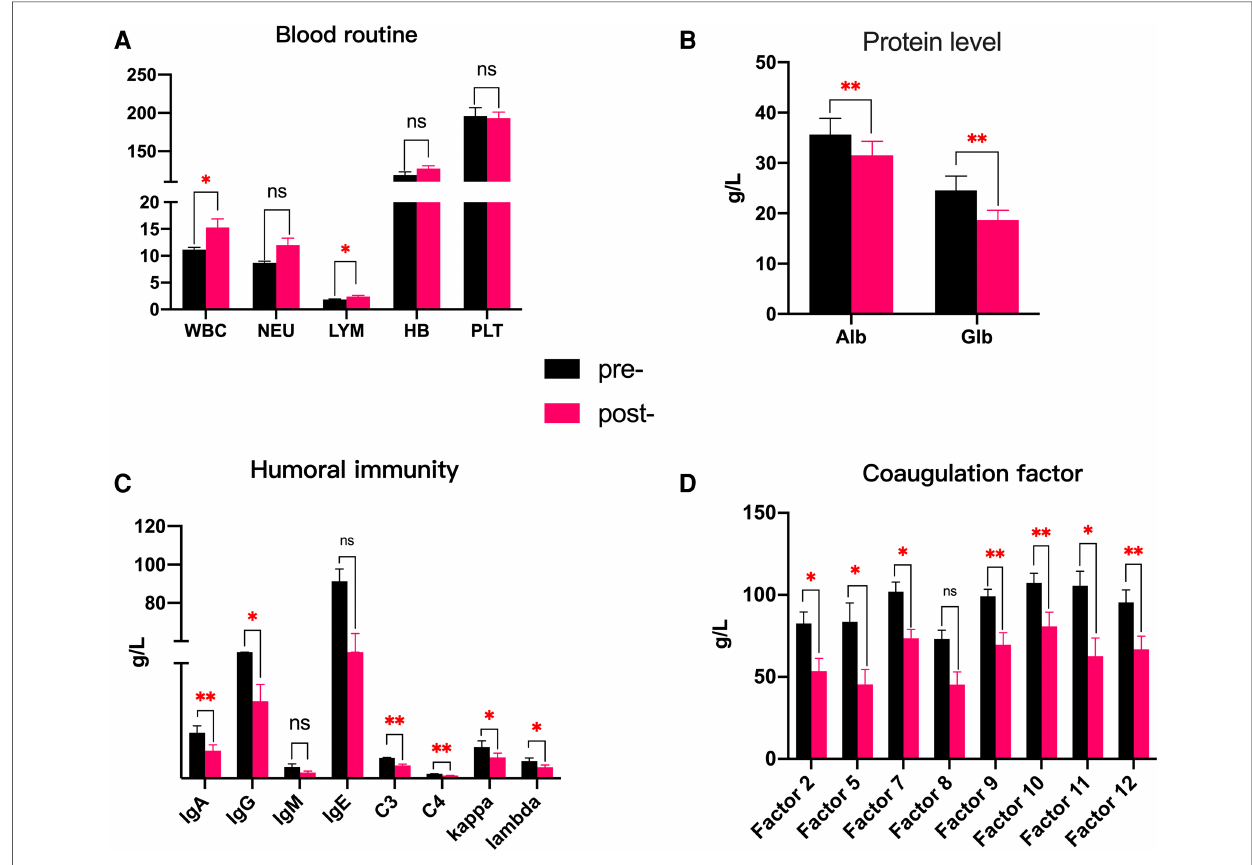
FIGURE 3 ( A – D ) Comparison of the changes in blood routine and protein levels pre- and post-DFPP treatment (case 1). * p <0.05; ** p <0.01; ns, not signi fi